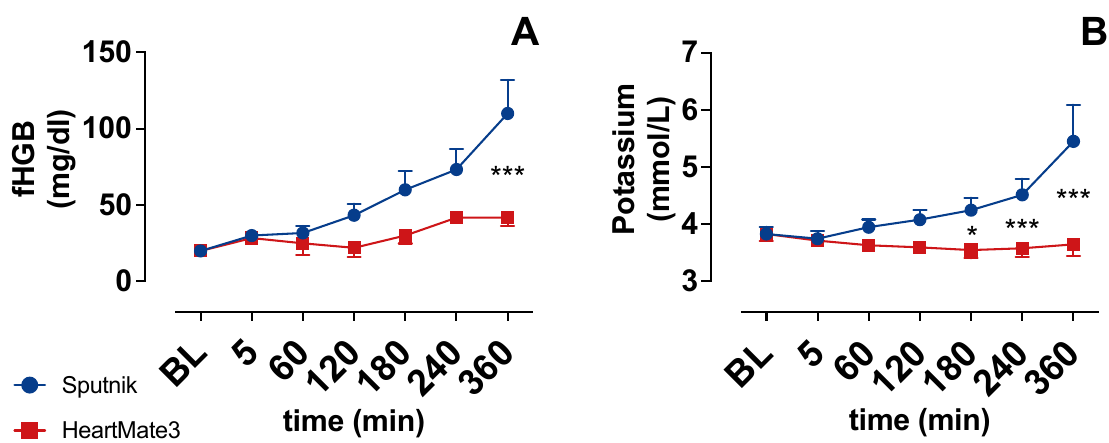
Figure 4. ( A ) Plasma free hemoglobin (fHGB) and ( B ) potassium over time. Baseline (BL). * p < 0.05; *** p < 0.001.